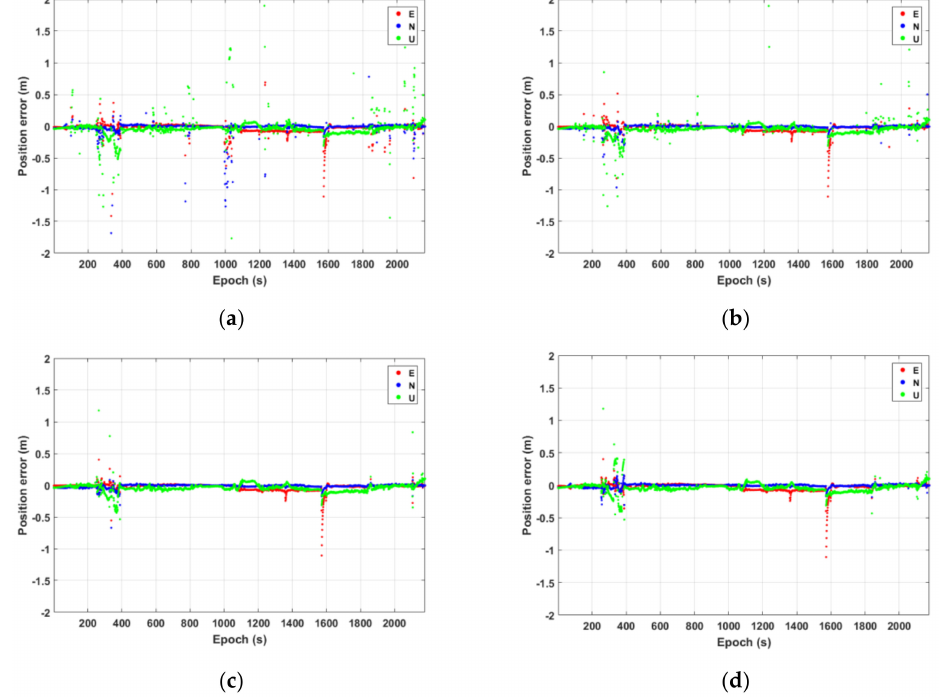
Figure 13. ( a ) Position accuracy of F9P − ADIS. ( b ) Position accuracy of F9P − XW. ( c ) Position accuracy of SEPT − ADIS. ( d ) Position accuracy of SEPT −